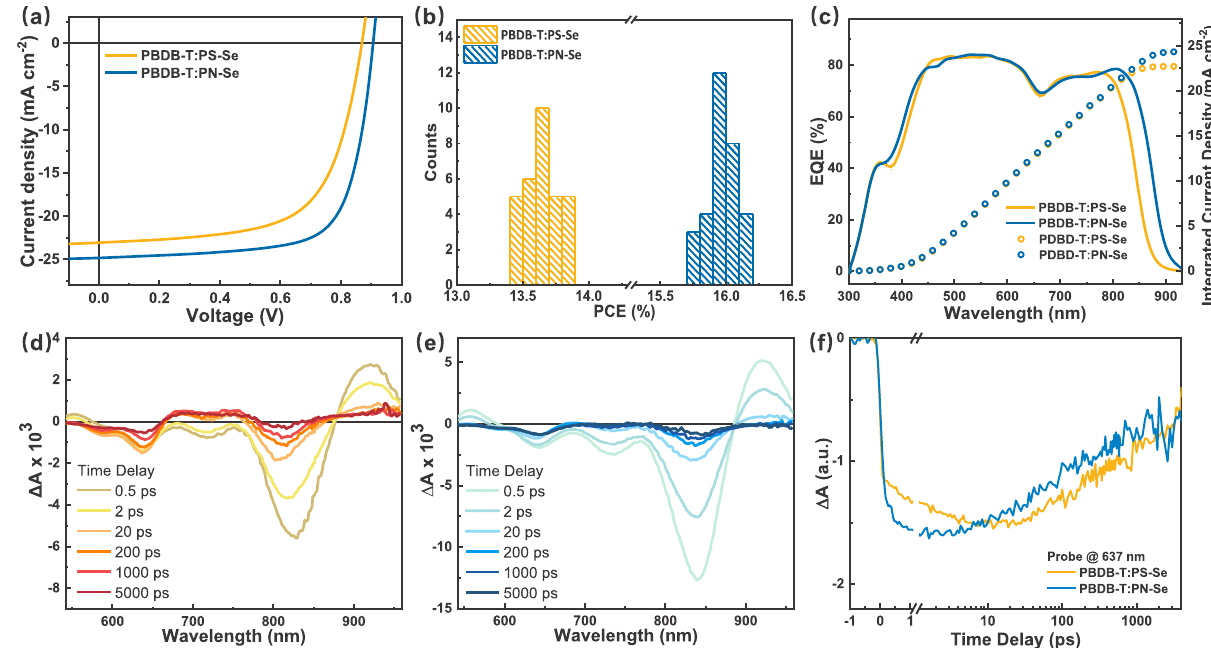
Fig. 6 Photovoltaic performance and transient absorption kinetics. a The J – V curves of the optimal all-PSCs under the illumination of AM1.5 G, 100 mWcm − 2 . b Histogram of PCE measurement for 30 devices based on PBDB-T:PS-Se (1.5:1, w/w) and 30 devices based on PBDB-T:PN-Se (1.5:1, w/w), measured under the illumination of AM1.5 G, 100 mW cm − 2 . c External quantum ef fi ciency (EQE) spectra of the corresponding all-PSCs. Femtosecond transient absorption spectra of ( d ) PBDB-T:PS-Se and ( e ) PBDB-T:PN-Se with excitation at 850 nm. f Transient kinetic traces of PBDB-T GSB probing at 637 nm for the blend fi lms.